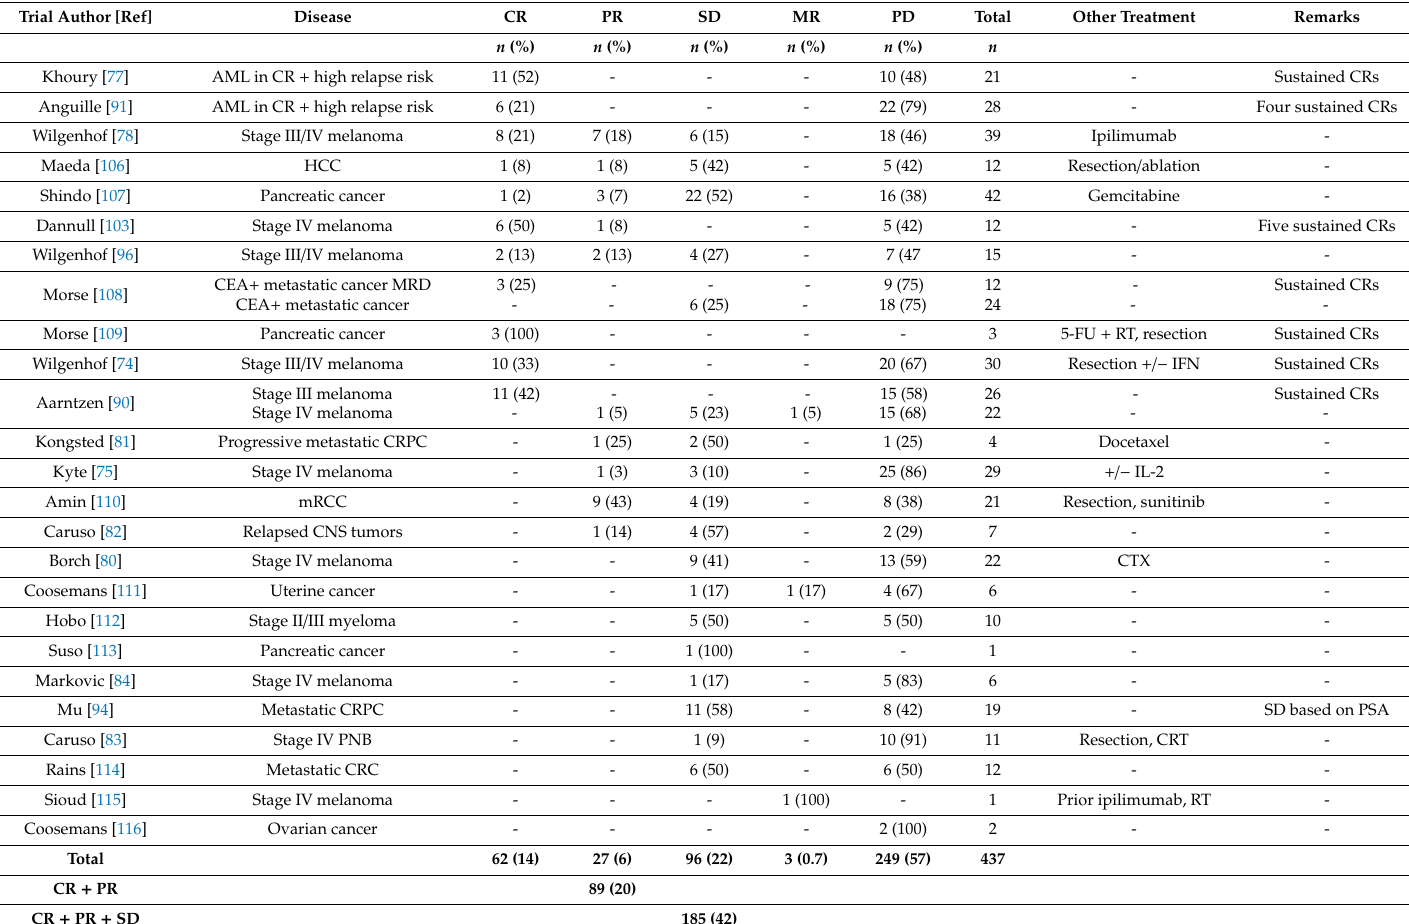
Table 2. Clinical responses following RNA-modified dendritic cell